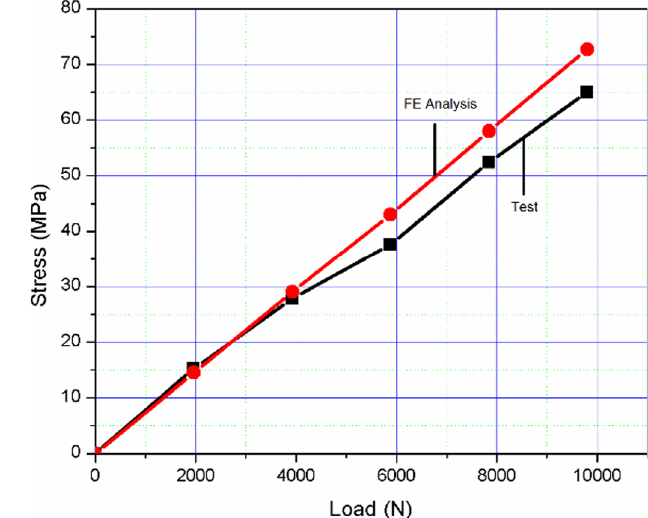
Fig. 8. Test & FE results at gauge-2 location.